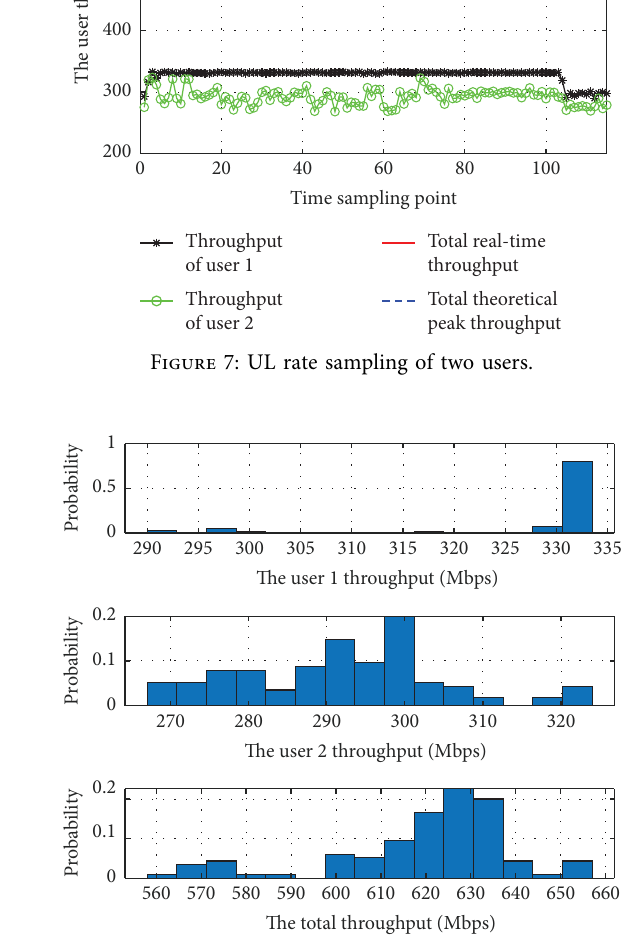
Figure 8: UL rate probability distribution of two users.